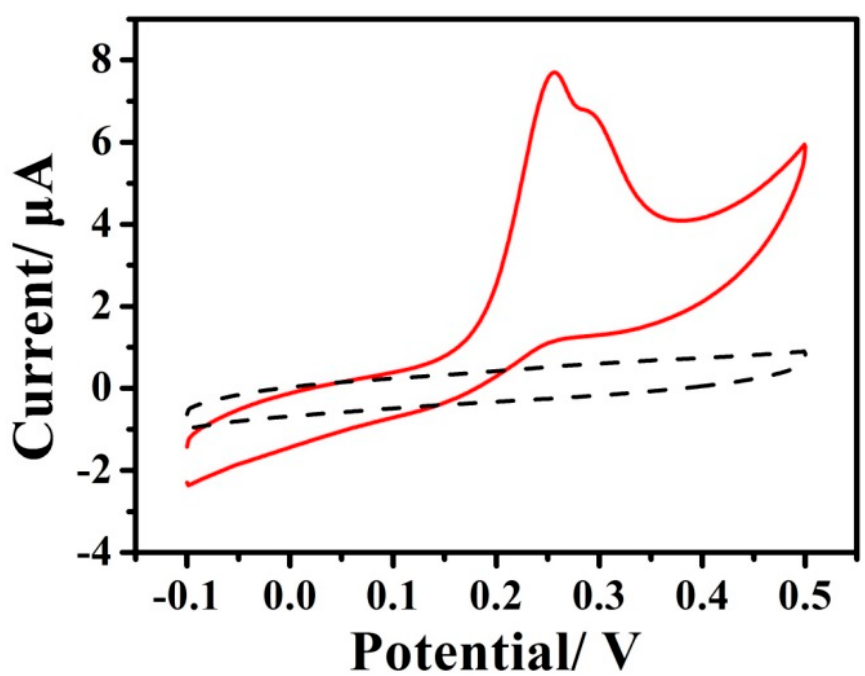
Figure 9. CV of PCs/CPE in the absence (dotted line) and presence (solid line) of 5 mM GSH in 0.1 M PBS (pH = 7.0). Scan rate: 50 mV s − 1 .